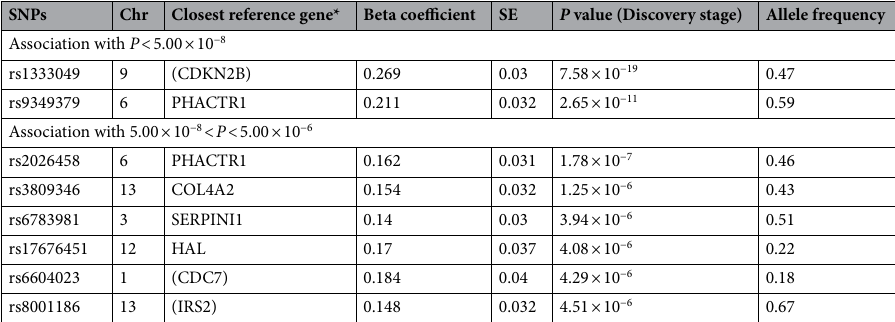
Table 1. Eight instrumental SNPs and their association summary reported at the discovery stage 15 . SNPs single-nucleotide polymorphisms; Chr chromosome; SE standard error; Sample size = 9961. *Genes for SNPs that are outside the transcript boundary of the protein-coding gene are shown in parentheses [e.g.,